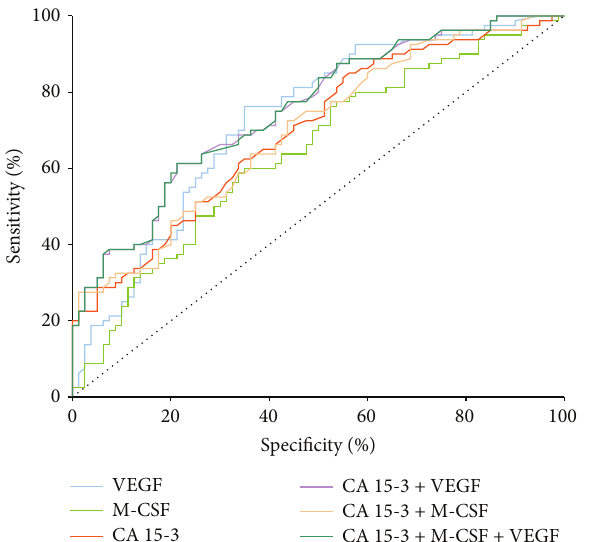
Figure 3: Diagnostic criteria of ROC curve for tested parameters and in combination with CA 15-3 in stage II of BC.